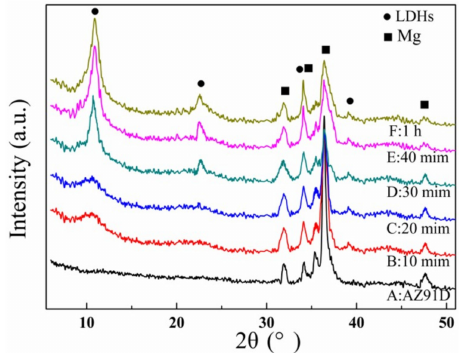
Figure 4. GAXRD patterns of the LDHs coatings at different formation times.